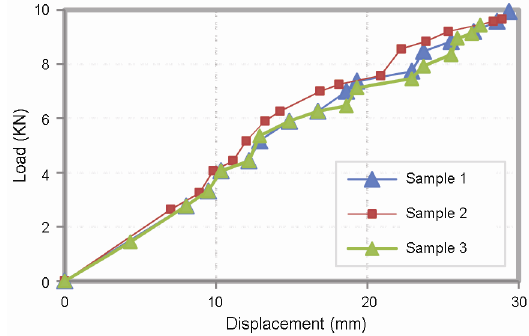
Fig. 14. Load-displacement curves for different specimens strengthened with two layers of GFRP but without surface pre- paration